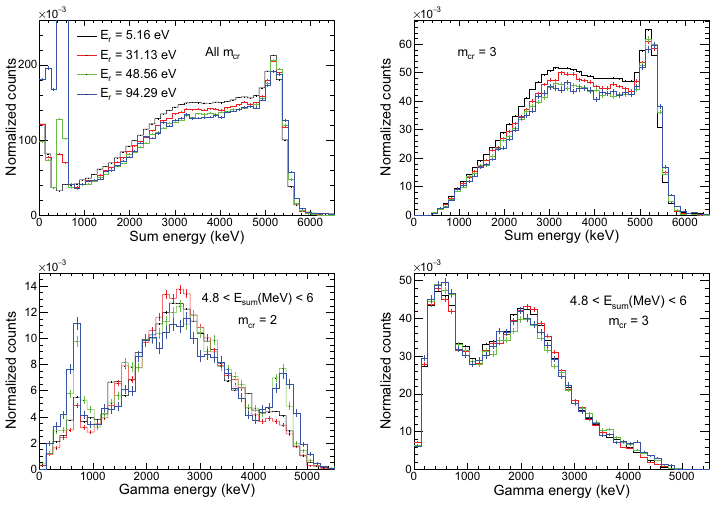
Figure 3. Sum-energy spectra of di ff erent resonances for all m cr and m cr = 3 (top). Multi-step γ -ray energy spectra of di ff erent resonances for m cr = 2 , 3 (bottom). The statistical uncertainties are small.